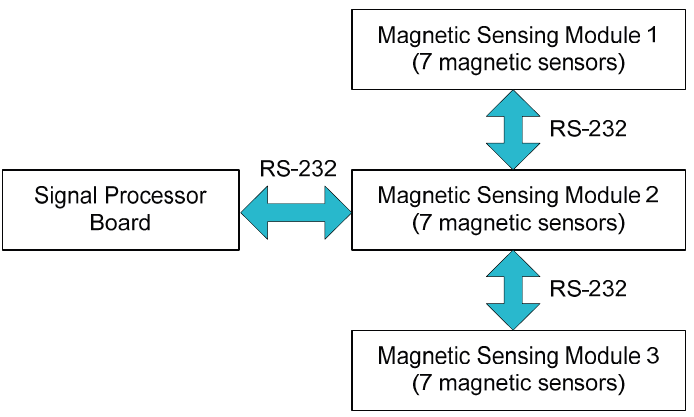
Figure 3. Design of MSR and data flow of magnetic